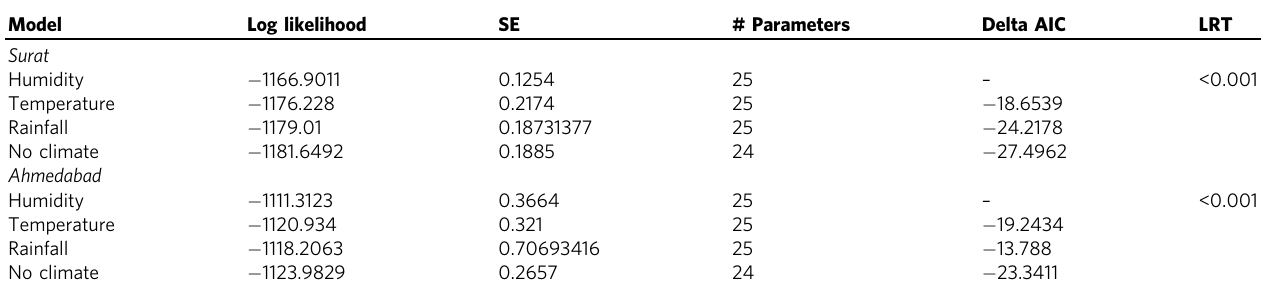
Table 1 Model comparison for both cities, where SE represents the standard error, and LRT is the result of a Likelihood ratio test to compare the likelihood of the model with the climate covariate to that of the null